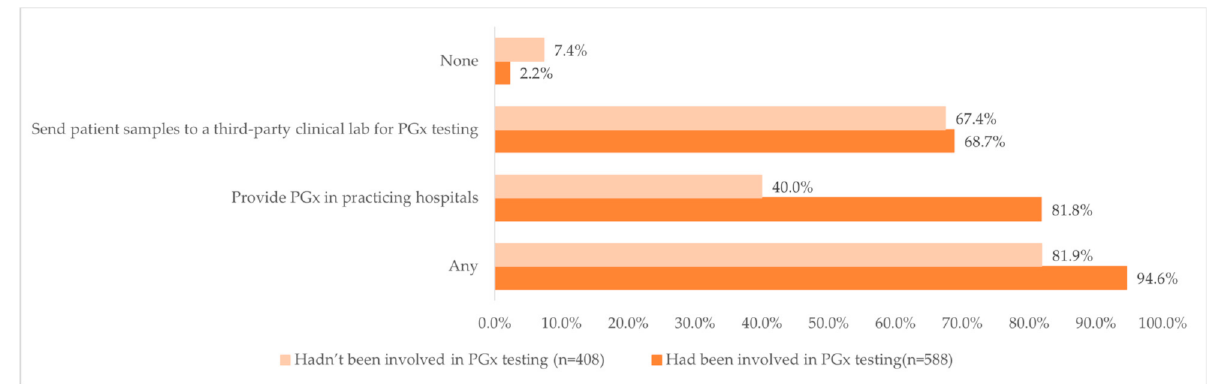
Figure 2. Distribution of the availability of PGx testing at the pharmacists’ work hospital and the clinical pharmacists’ involvement in PGx